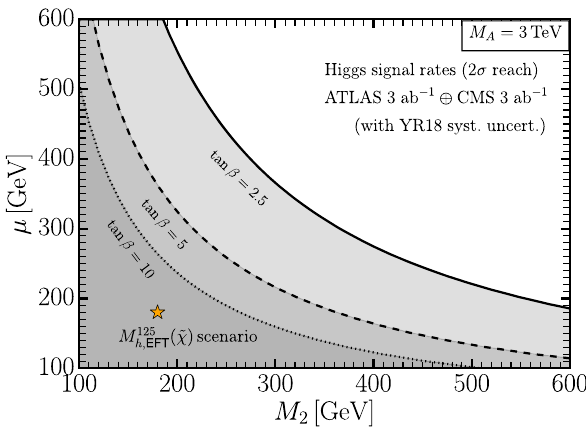
Fig. 5 Projected reach of future Higgs signal rate measurements at ATLAS and CMS with 3 ab − 1 assuming YR18 systematic uncertainties ( ˜ χ) scenario(denoted inthe( M 2 , μ )parameterplanearoundthe M 125 h , EFT bytheorangestar),forfixed M A = 3 TeV.Thesolid,dashedanddotted contour lines and the corresponding gray areas indicate the 2 σ reach for tan β values of 2 . 5, 5 and 10, respectively